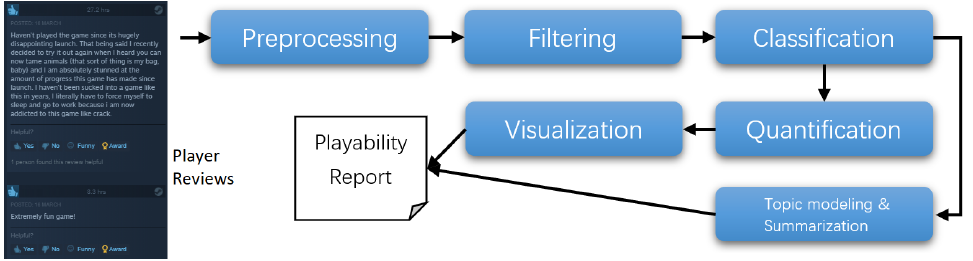
Figure 1. Video Game Playability Evaluation